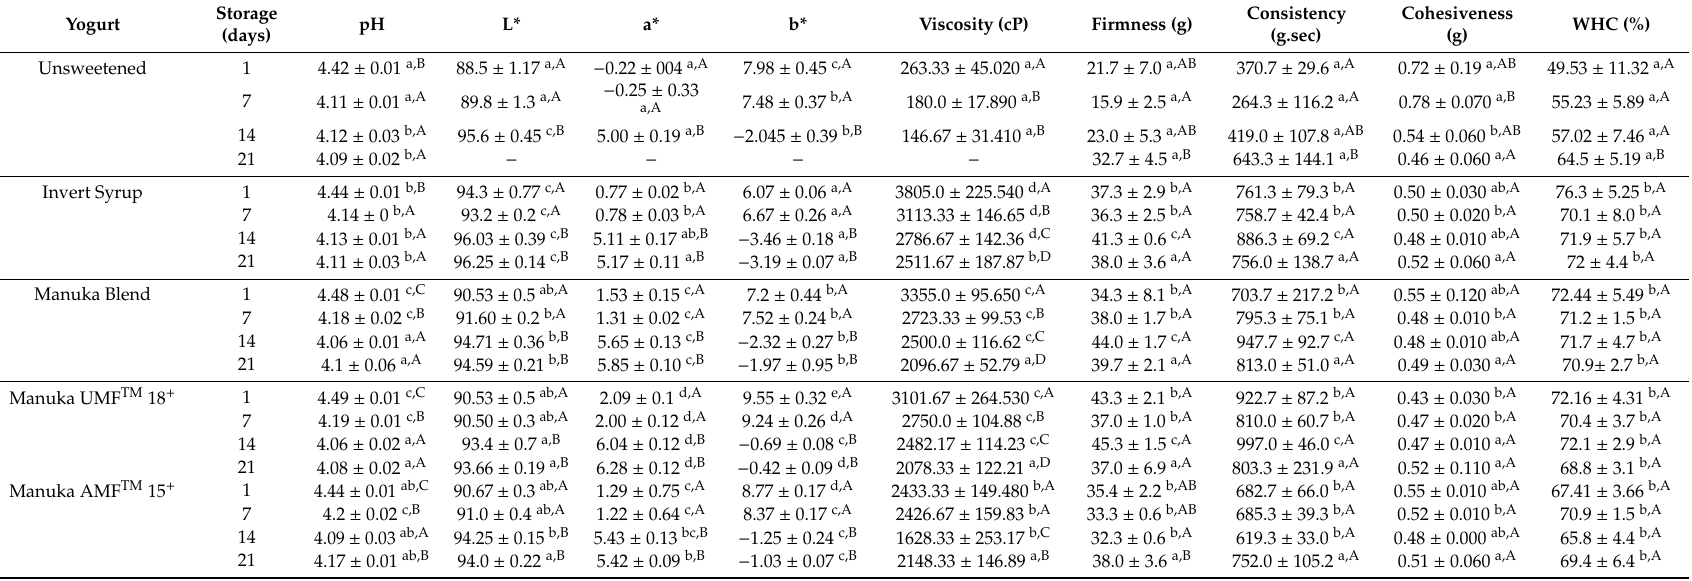
Table 2. Physicochemical properties (mean ± standard deviation) of yogurts with three di ff erent honey and controls over the refrigerated storage period (21 days). Storage Yogurt